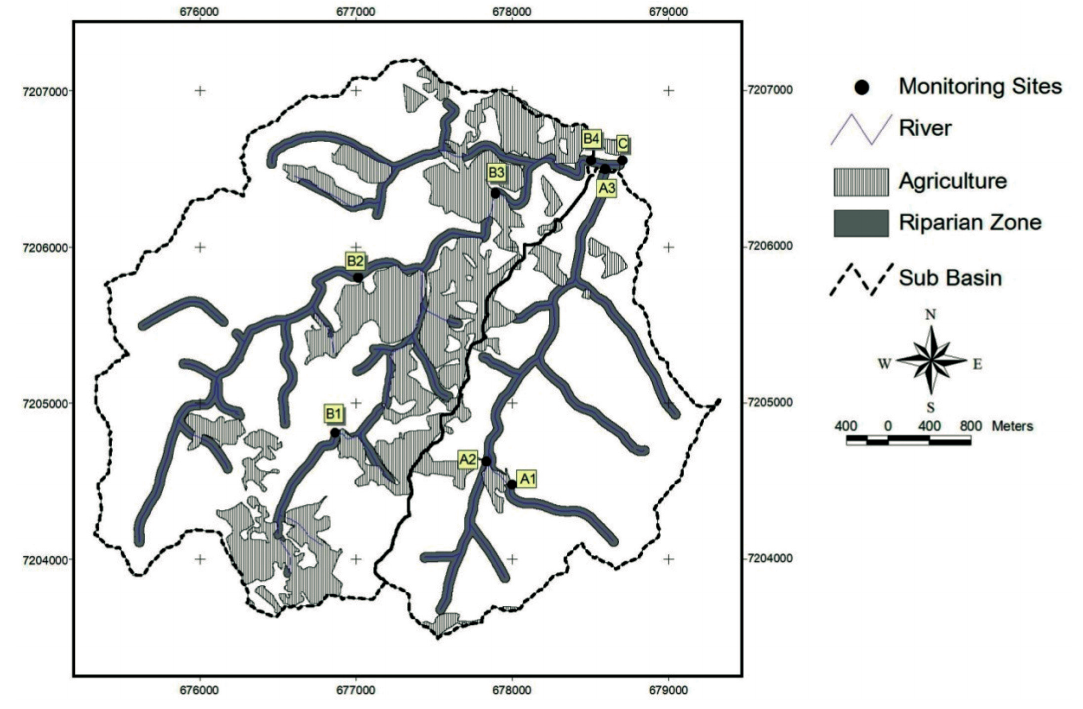
catchment.Figure 4. Agricultural area and riparian vegetation in the Campestre